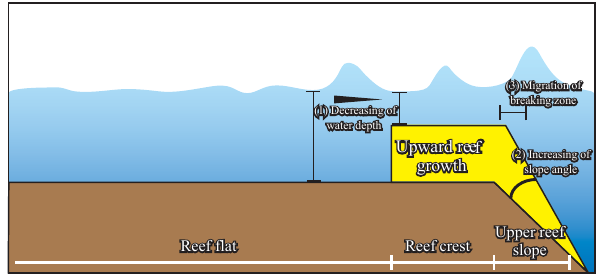
Figure 9. Effects of reef growth on reduction in wave height at the reef flat. In the reef crest to upper reef slope zone, upward reef growth will cause (1) a decrease in water depth, (2) an increase in the reef slope angle, and (3) migration of the wave breaking zone towards the outer ocean. These processes will enhance wave break- ing in the reef crest to upper reef slope zone relative to degraded reef. Consequently, wave height on the reef flat will be